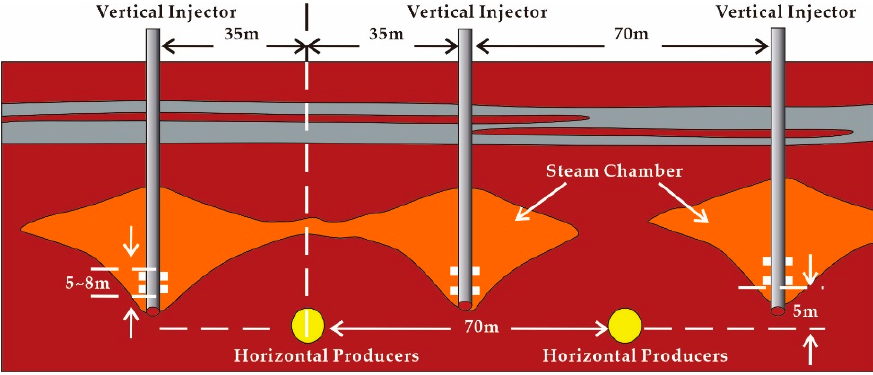
Figure 1. The schematic diagram of SAGD.